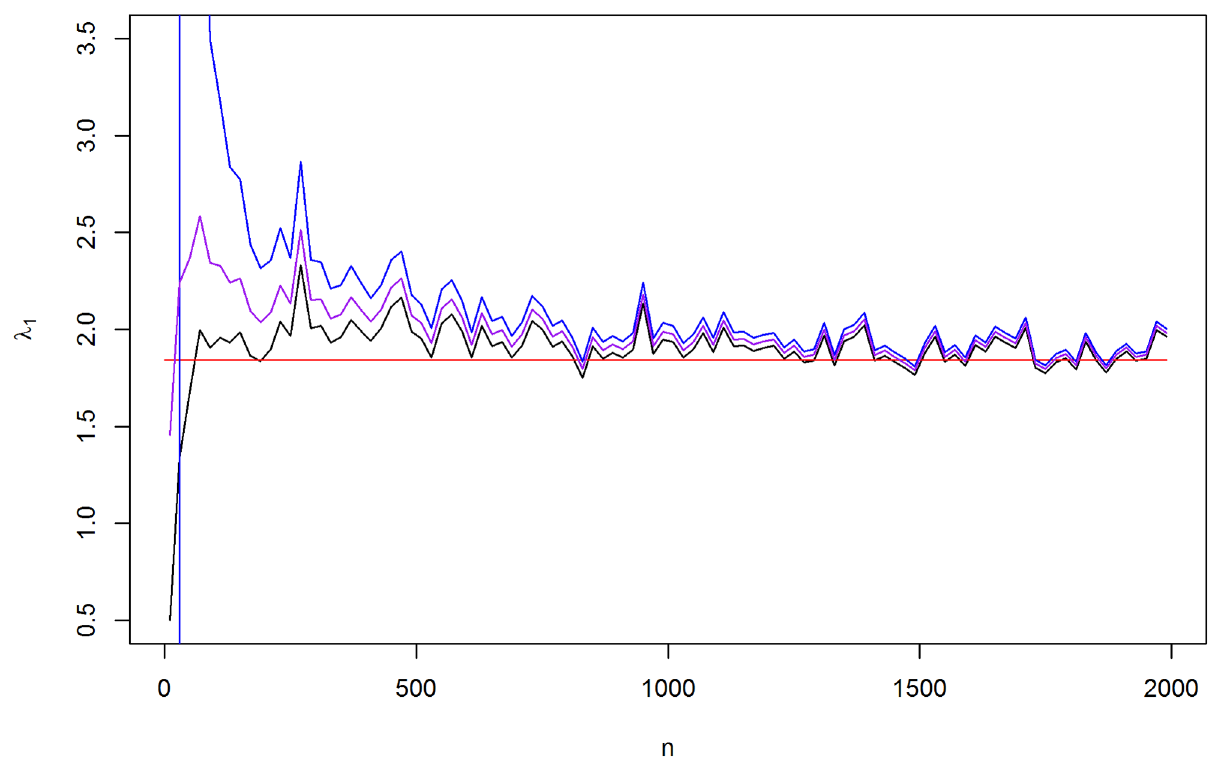
Fig 1. The shrinkage of the largest eigenvalues. The largest eigenvalue of MAP (black line), ML-estimate (blue line), posterior mean (purple line) and the real eigenvalue of Θ (red line) when the data is sampled from N(0, Θ − 1 ) distribution with sample size n and p = 20.